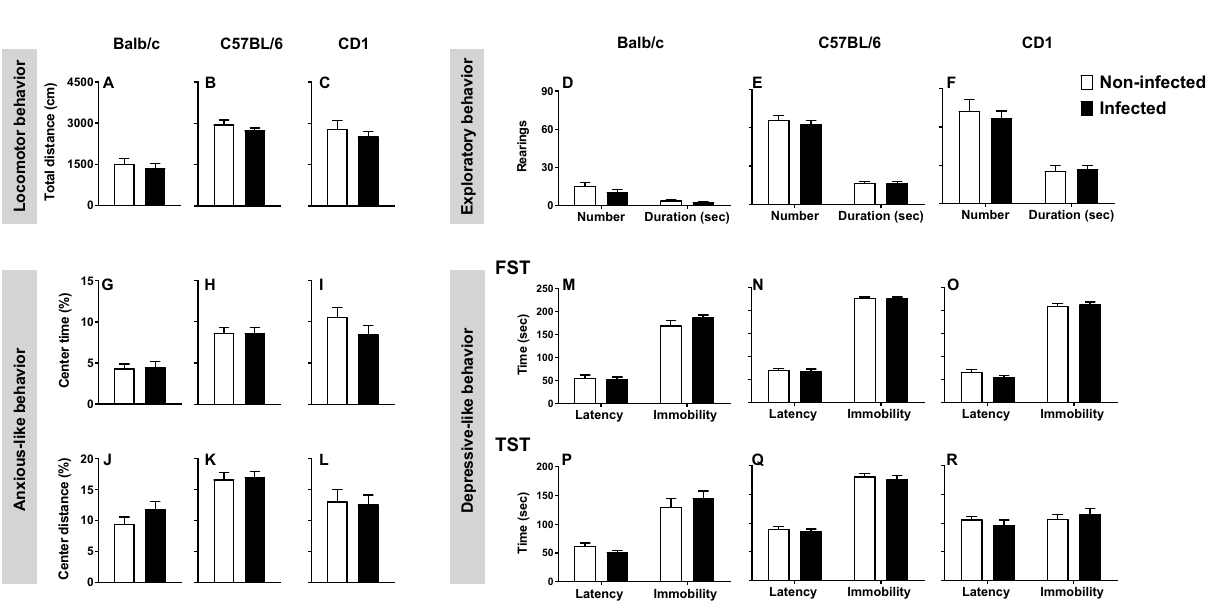
Figure 6. M. avium chronic infection does not induce alterations in locomotor, exploratory, anxious-like or depressive-like behaviors. The OF, FST and TST tests were performed with non-infected and infected (4wpi) Balb/c, C57BL/6 and CD1 female mice. In the OF arena, the total distance travelled in centimeters ( A – C ), the number and duration of rearings ( D – F ), the percentage of time in the center of the arena ( G – I ) and center distance ( J – L ) were scored . In the FST ( M – O ) and TST ( P – R ) the latency until the first immobility and duration of the immobility periods were assessed. Each bar represents the mean + SEM of 15–23 mice per group, from 1 of 3 independent experiments. *P <